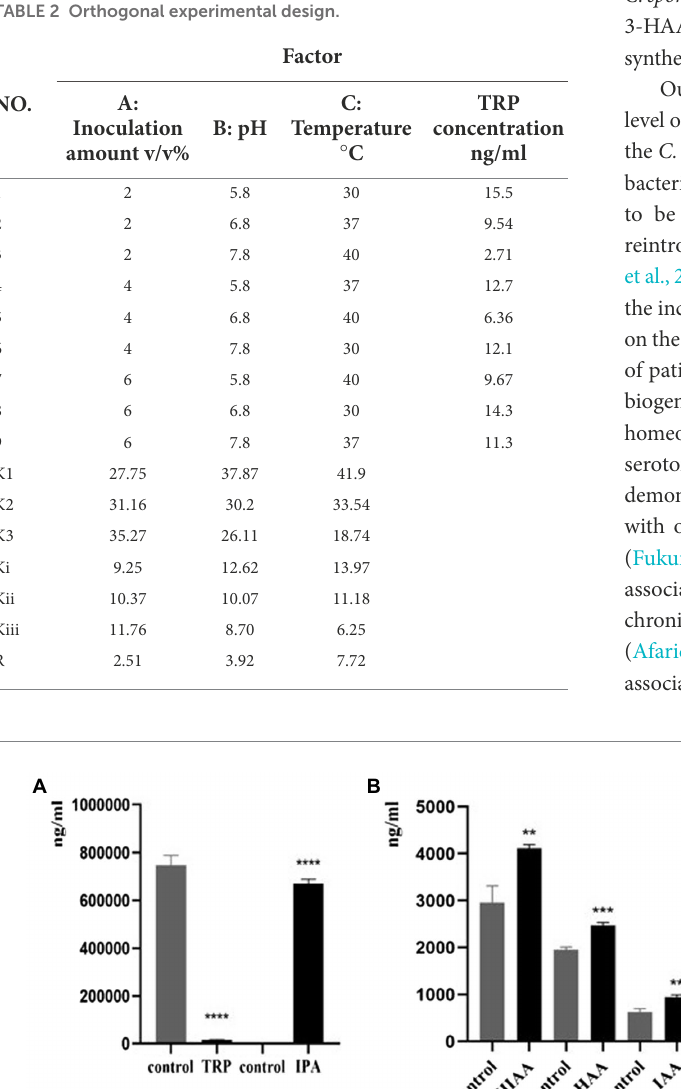
TABLE 2 Orthogonal experimental design.